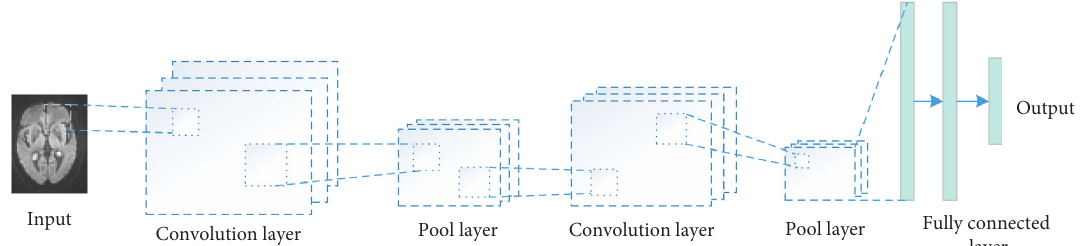
Figure 1: Convolution neural network structure of medical image.